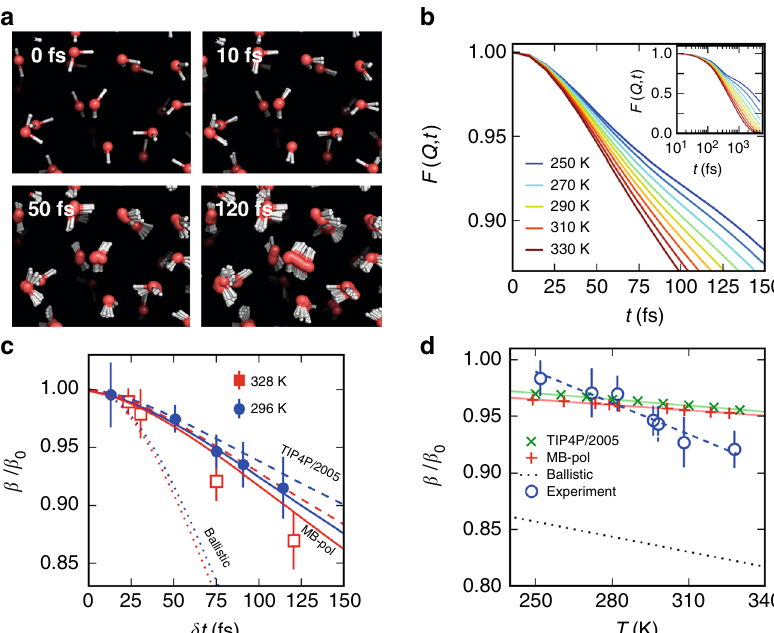
Fig. 5 Molecular dynamics simulations and comparison to experiment. a Snapshots from the simulations for different exposure times comparable to the experiment. b The intermediate scattering function F ( Q,t ) obtained from TIP4P/2005 at different temperatures. The inset depicts F ( Q,t ) over longer times in logarithmic scale. c Comparison of the normalized speckle contrast between theory and experiment. The symbols are the experimental data at two different temperatures (circles 296 K, squares 328 K). The lines are simulated values using TIP4P/2005 (dashed) and MB-pol (solid), while the dotted lines correspond to the purely ballistic case at temperatures 300 K (blue) and 330 K (red). d Comparison of the speckle contrast as a function of temperature as estimated from the experiment (circles) with simulations (crosses MB-pol, x ’ s TIP4P/2005) and the purely ballistic case (dotted line) at δ t = 75 fs. The lines depict linear fi ts to highlight the difference in slope between experiment and simulations. The errorbars in c and d correspond to the standard